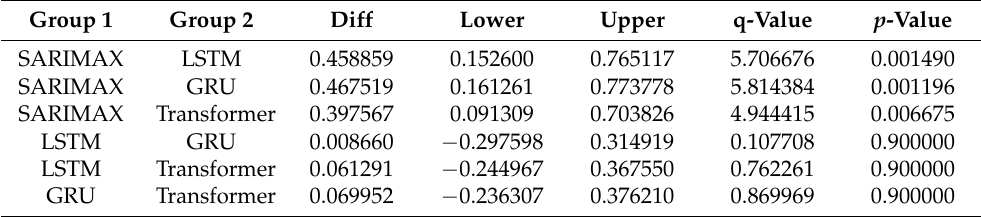
that the null hypothesis is